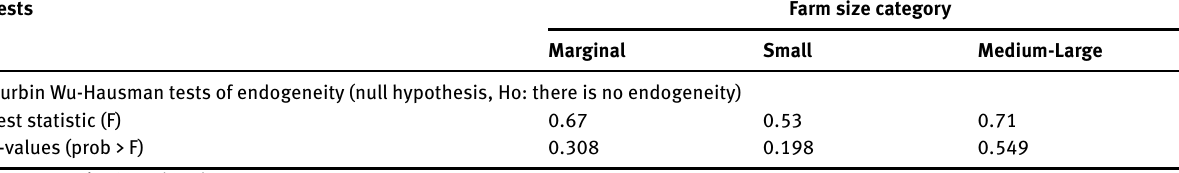
Table 3: Endogeneity test